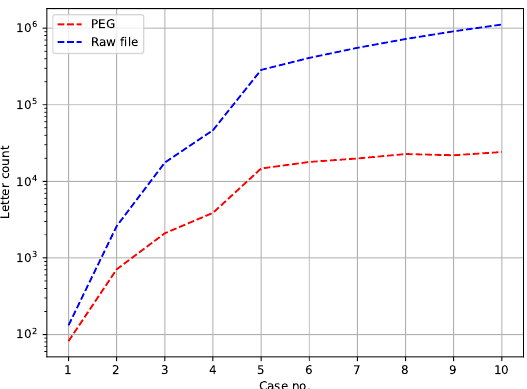
Figure 3. The number of symbols in a PEG (red line) and the number of letters in a respective test set (blue